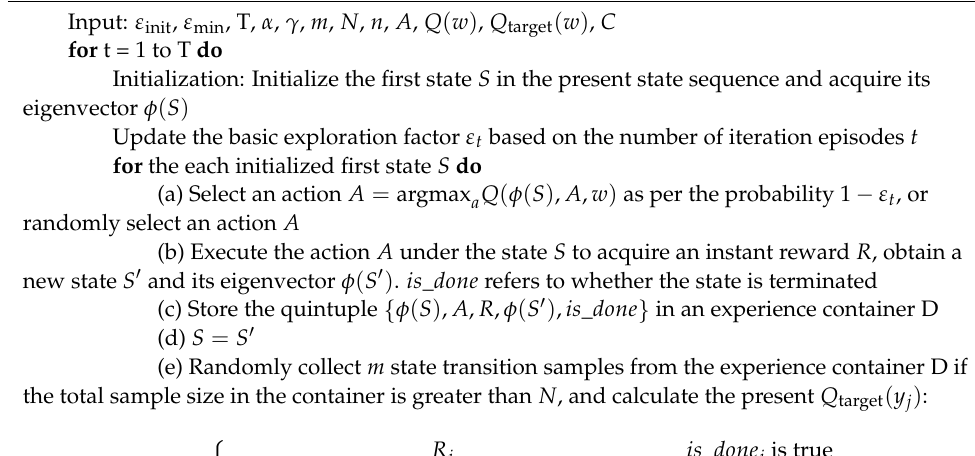
Algorithm 2: Pseudo form of the DDQN